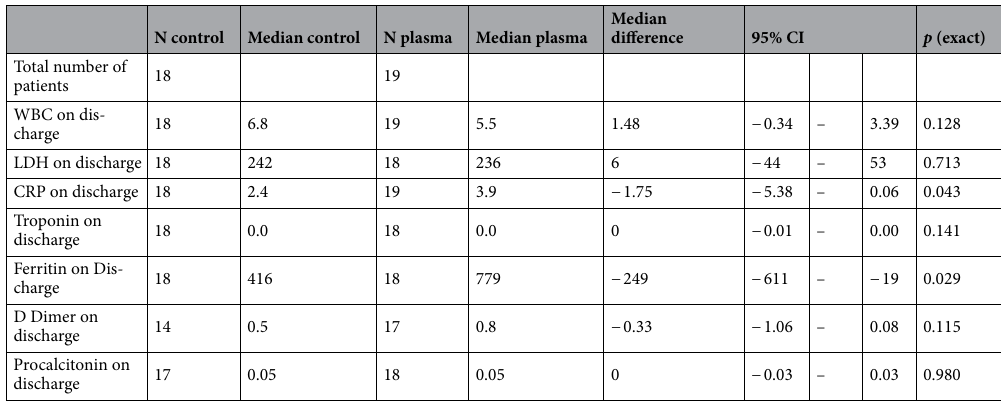
Table 4. Secondary outcome measures between plasma (n = 20) and control patients (n =